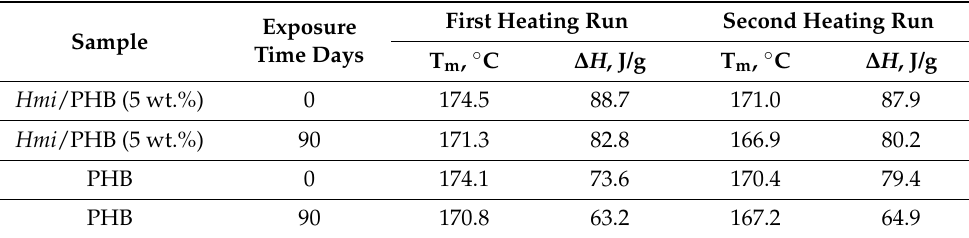
Table 3. Thermophysical characteristics (T m —the melting temperature, ∆ H —the heat of fusion) of weathered PHB and Hmi /PHB nanocomposites (90 days of